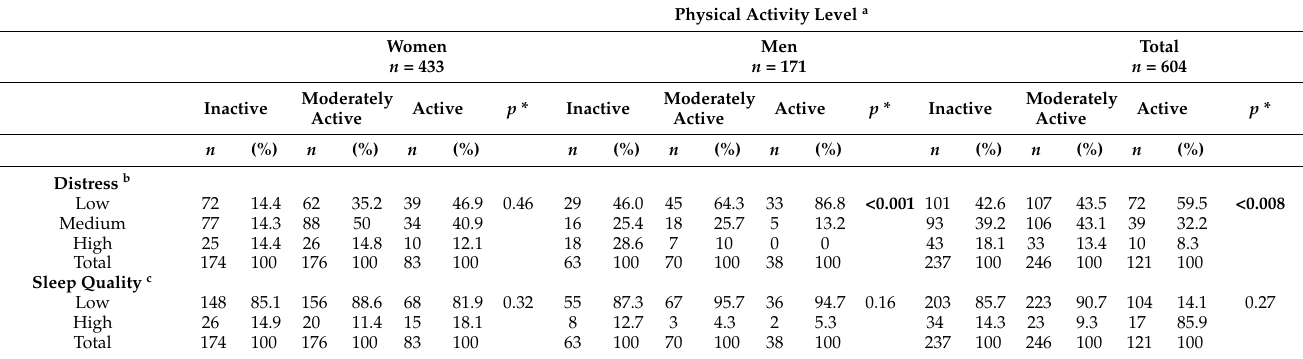
(60%; p < 0.008). Among active men 87% reported low distress ( p < 0.001) while this was Table 5. Correlation between physical activity and sleep quality and distress in total subjects and by sex.